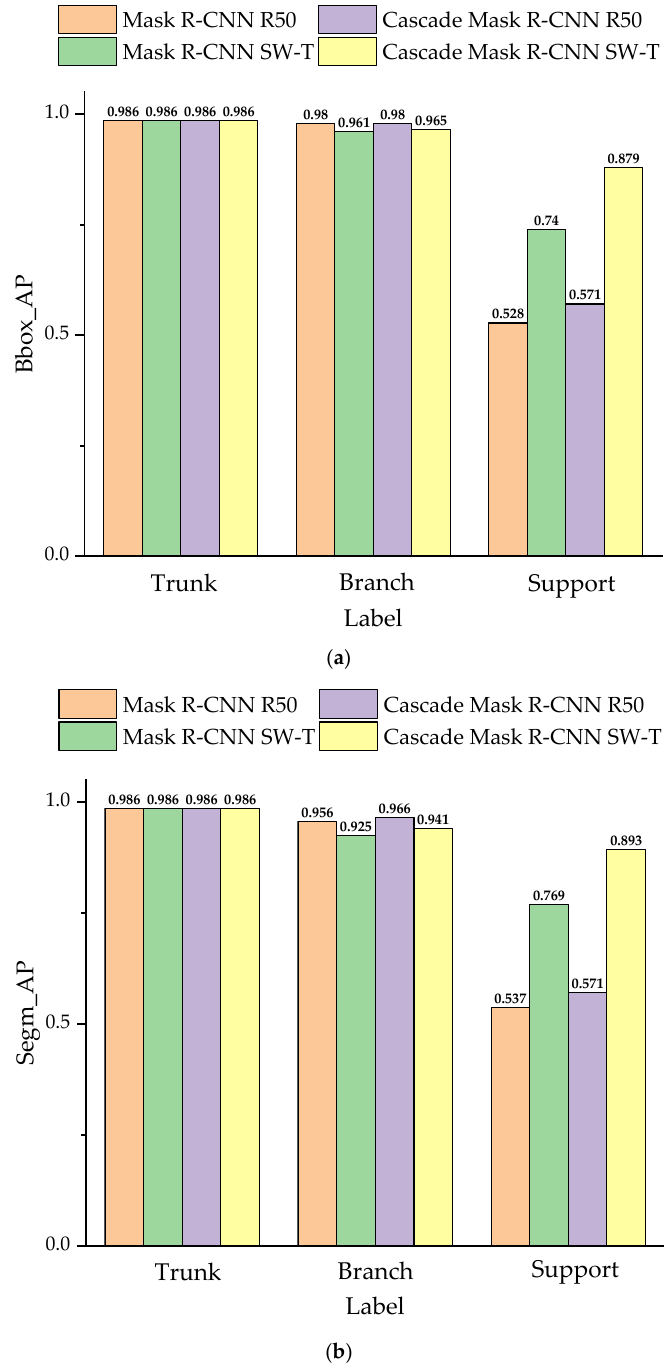
Figure 9. AP values of each category when the IoU threshold is 0.5: ( a ) bbox AP of each category; ( b ) segm AP of each